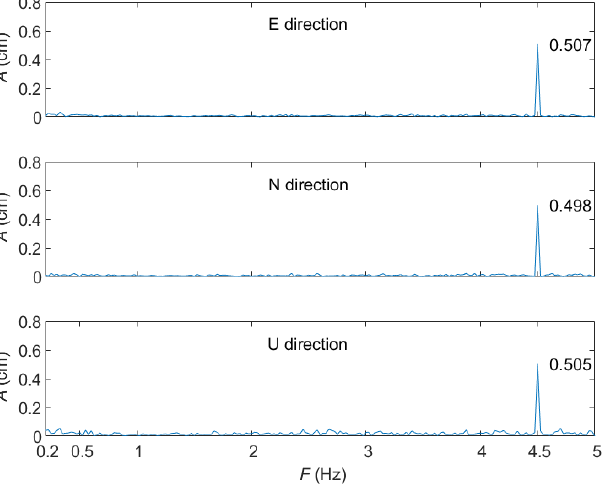
Figure 14. FFT spectrum of the high-frequency vibrational behavior ( A = 0.5 cm, F = 4.5 Hz).